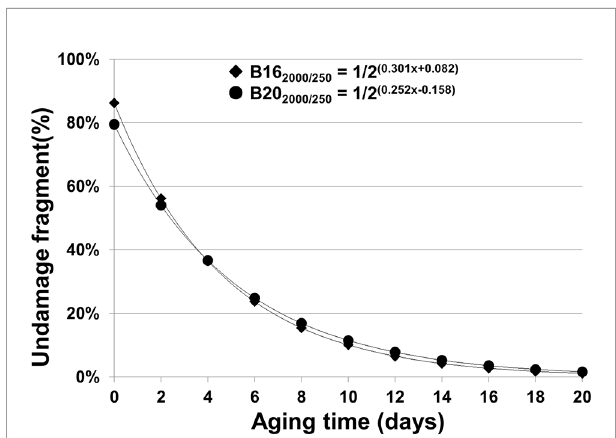
FIGURE 6 | Percentage of estimated undamaged mRNAs of B16 and B20 in seeds with different arti fi cial aging time (days). We have derived mathematical equations to estimate the relative amount or percentage of undamaged stored mRNAs based on the D Ct regression functions. The regression functions for different fragments of B16 and B20 are from Figures 3C, D . For B162,000/250bp, the percentages at different aging times were calculated based on the equation: y = 1/2 D Ct(B162,000/250bp) × 100% = 1/2(0.301+ 0.082)100%, while for B202,000/250bp, the equation is y = 1/2 D Ct (B202,000/250bp) × 100% = 1/2(0.252+ 0.158)